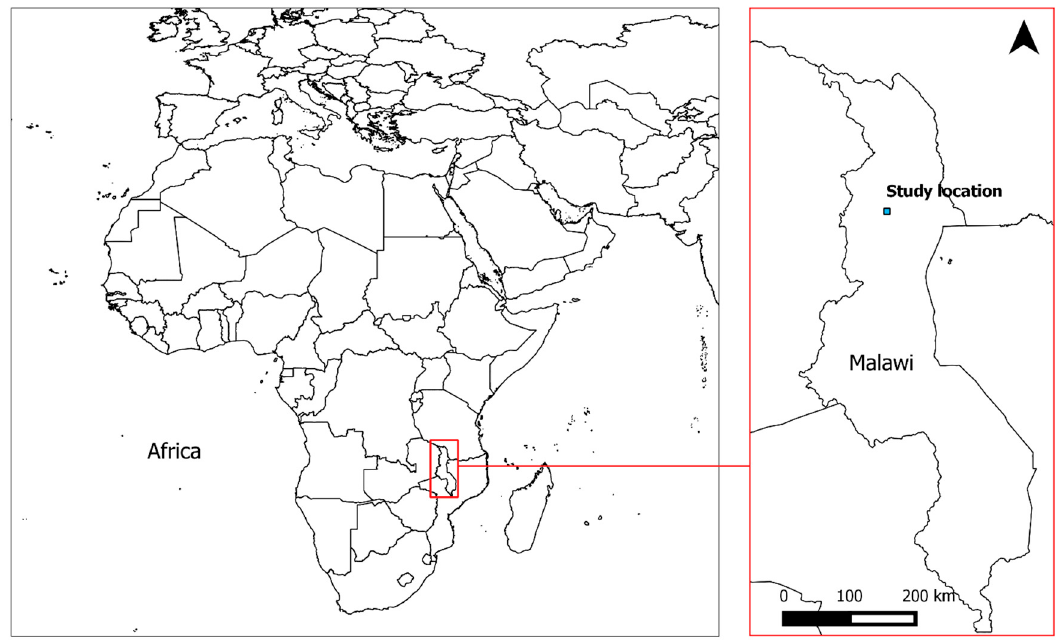
Figure 2. Location of the study area where switching from currently grown crops (maize, chillies, paprika, groundnuts, and tobacco) to sericulture is being considered.